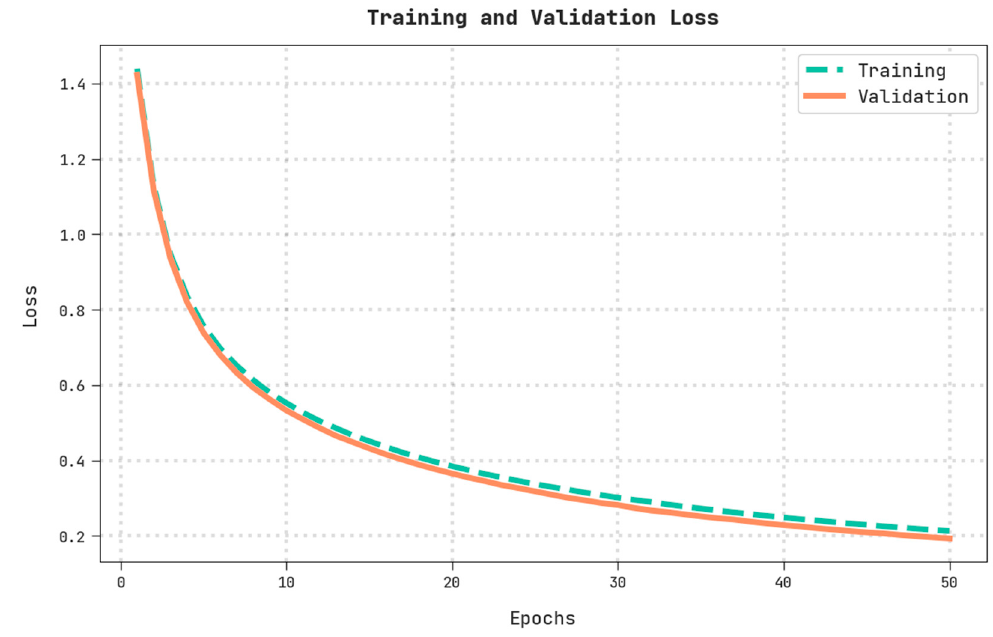
Figure 8. TRL and VLL analysis of CLBEDC-SND approach.